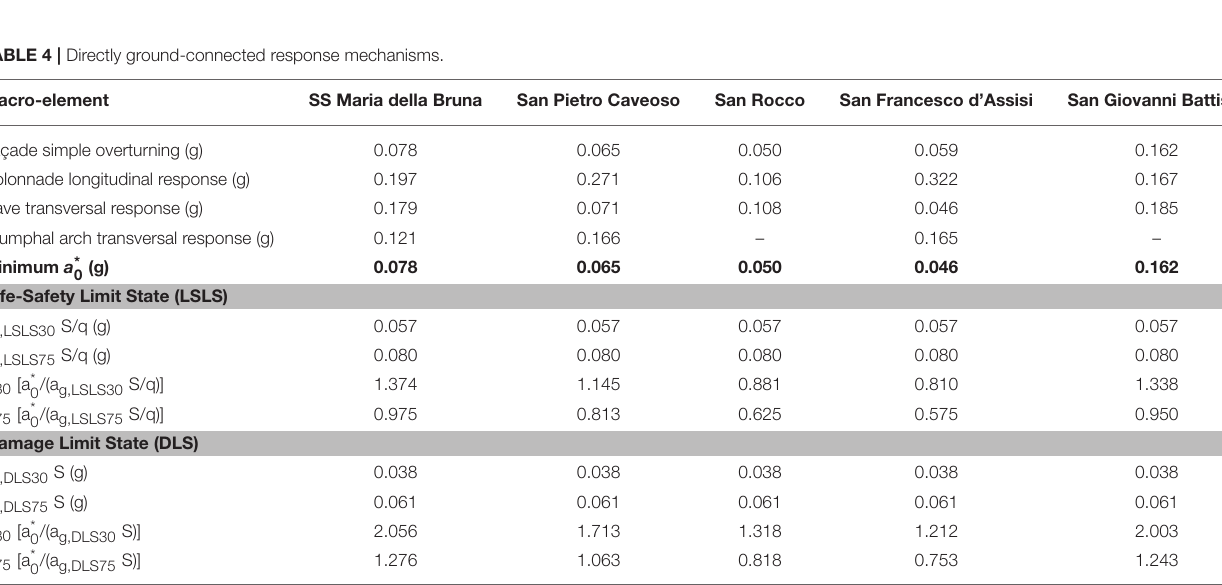
FIGURE 4 | SS Maria della Bruna church. Response mechanisms considered: (A) Façade simple overturning, (B) longitudinal response of the colonnade, (C) triumphal arch transversal response, (D) lateral nave transversal response, (E) top façade overturning, (F) gable simple overturning, (G) gable out-of-plane breakout.